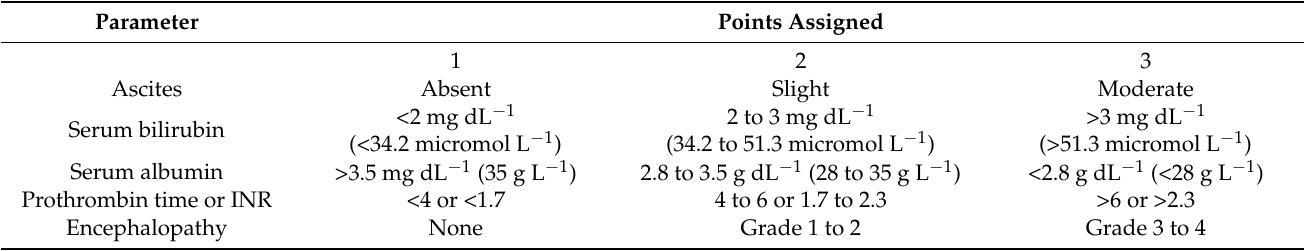
Table 3. Child–Pugh classification.